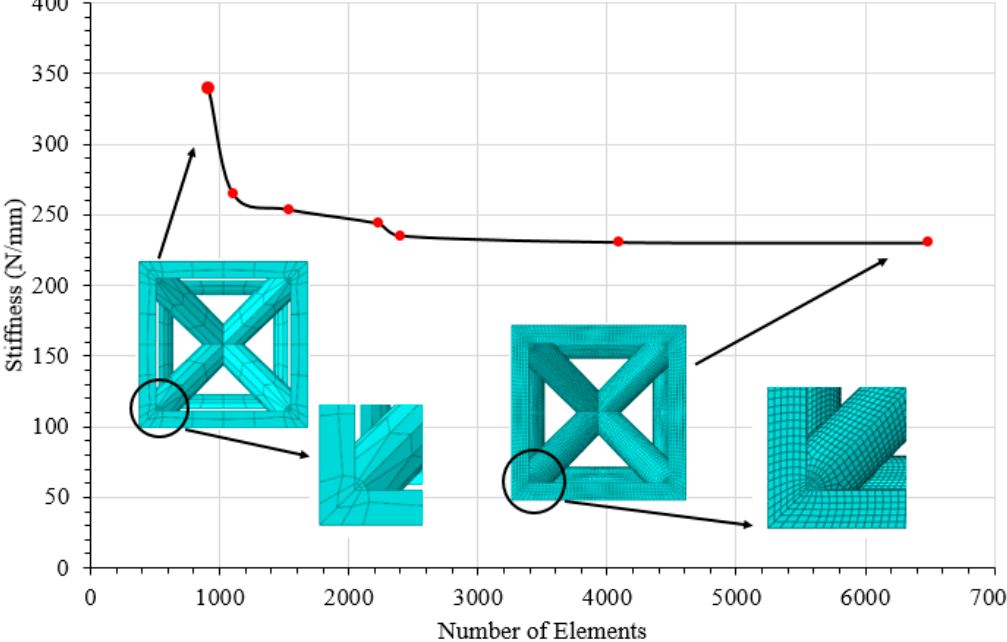
Figure 6. Mesh sensitivity study of the InsideBCC unit cell (5 × 5 × 5) mm and d = 1 mm for mesh size from 1.25 mm (coarse) to 0.19 mm (fine).